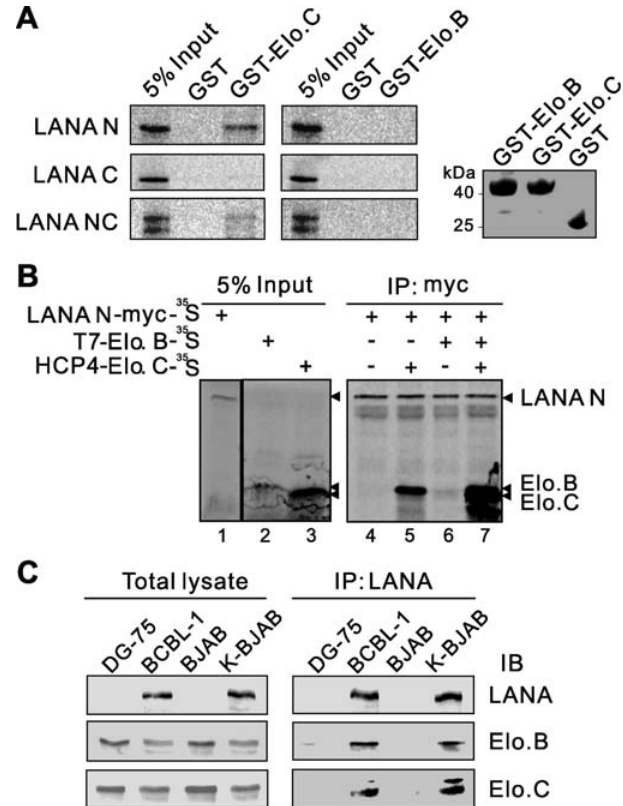
Figure 1. LANA Associates with the Elongin BC Complex (A) The amino-terminal domain of LANA directly interacts with Elongin C but not Elongin B in vitro. The cDNA encoding N (1–340 aa), C (762-1162 aa), or NC (1–327 ^ 929-1162 aa) truncation of LANA with myc tagged were expressed in a coupled transcription/translation system in the presence of [ 35 S]methionine. Aliquots (20 l l) of the translation products were pulled down by GST, GST–Elongin C, or GST–Elongin B, respectively. The pulldown complex as well as a 1- l l aliquot of the transcription/ translation reaction (Input) were fractionated by SDS-PAGE, and detected by a PhosphorImager. The proteins of GST and GST fused with Elongin B or Elongin C were shown by Coomassie staining in the right panel. (B) Elongin C is critical for LANA binding to Elongin B. In vitro produced and [ 35 S]-labeled proteins LANA N (1–340 aa), Elongin C, and Elongin B were incubated with anti-myc antibodies. The interacting complexes were resolved by SDS-PAGE and examined by a PhosphorImager. (C) LANA associates with Elongin BC complex in KSHV-infected cells. Cell lysates of BCBL-1, DG-75, BJAB, or BJAB with KSHV infection (K-BJAB) were subjected to IP against LANA or Elongin C (Elo. C) followed by IB against LANA, Elongin C, and Elongin B (Elo.